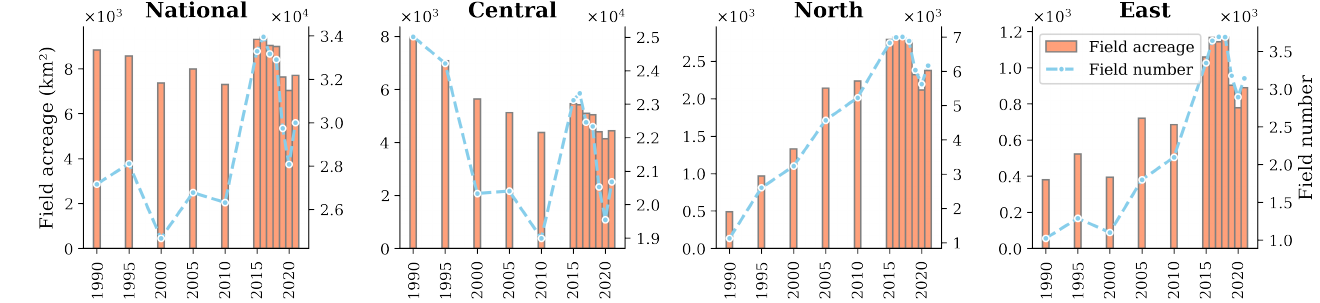
Figure 8. The acreage ( left y -axis related to bars) and number ( right y -axis related to dashed lines) of center-pivot fields from 1990 to 2021 at the national scale of Saudi Arabia and for the three sub-regions (i.e., the central, north, and east regions as shown in Figure